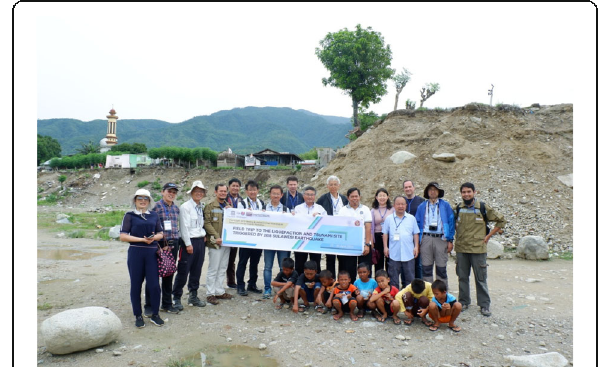
Fig. 7 Group Photo in Balaroa